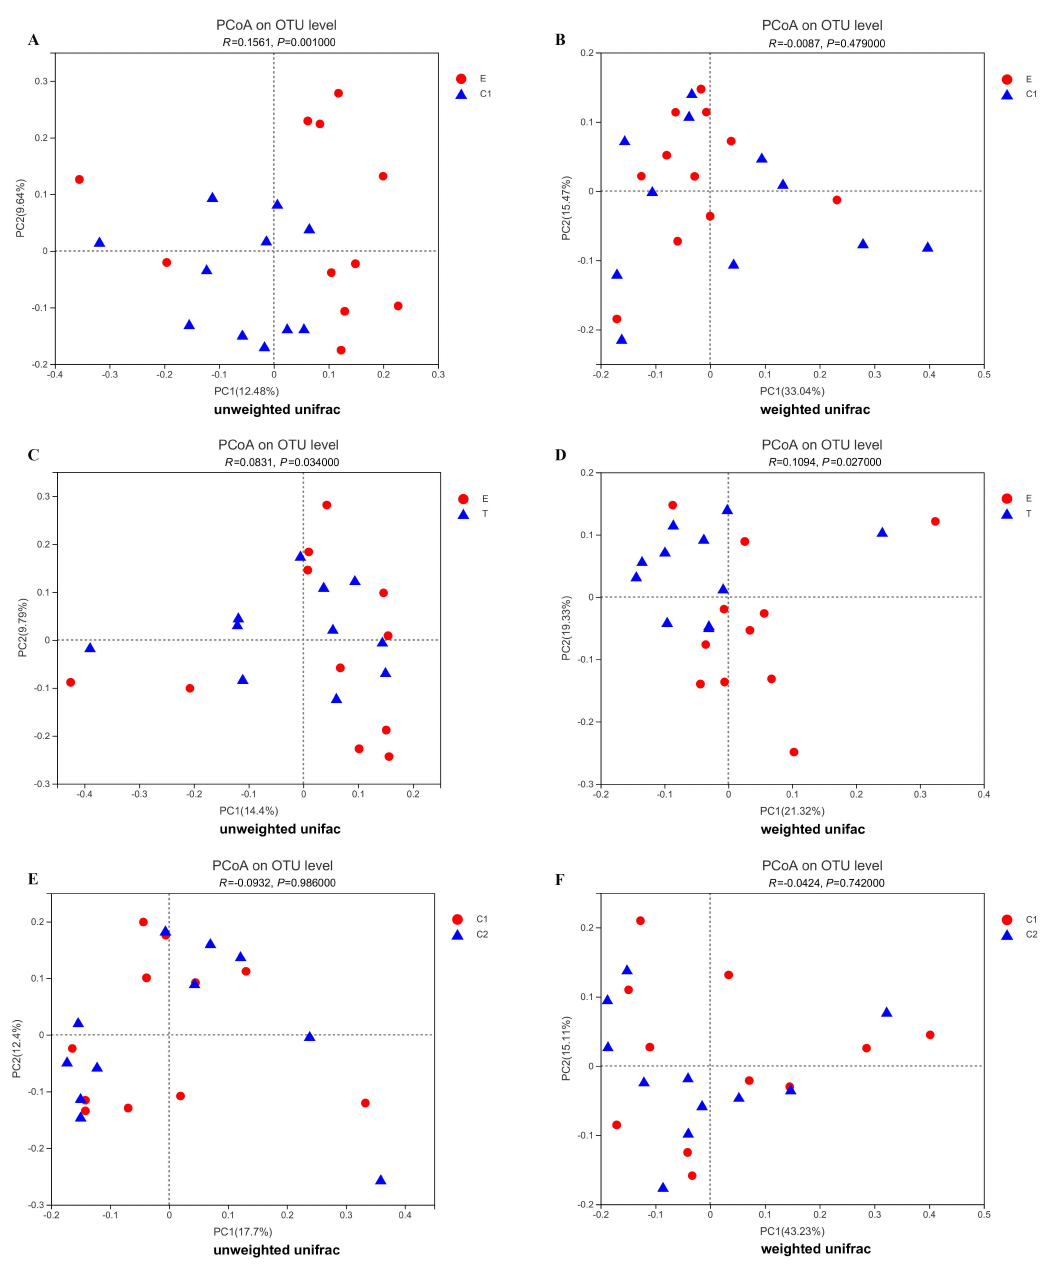
Figure 2. PCoA based on the unweighted UniFrac metrics ( A , C , E ) and weighted UniFrac metrics ( B , D , F ) of the fecal samples from the pre − exercise and post − exercise groups. Each shape in the figure represents a sample, and shapes of different colors indicate different groups. The percentage in the coordinate axis bracket represents the proportion of sample difference data (distance matrix), which the corresponding coordinate axis can explain. PCoA: principal coordinate analysis; E: experimental group before exercise intervention; T: experimental group after exercise intervention; C1: control group before exercise intervention; C2: control group after exercise